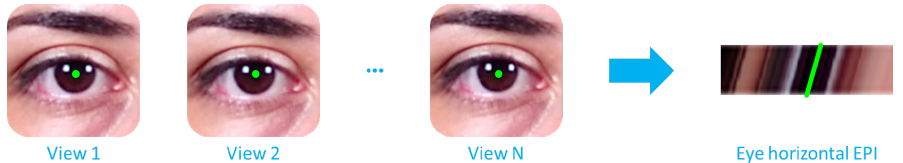
Figure 6. Level line: a 3D point lies on a straight line in the epipolar plane image. Eye image extracted from the IST-EURECOM